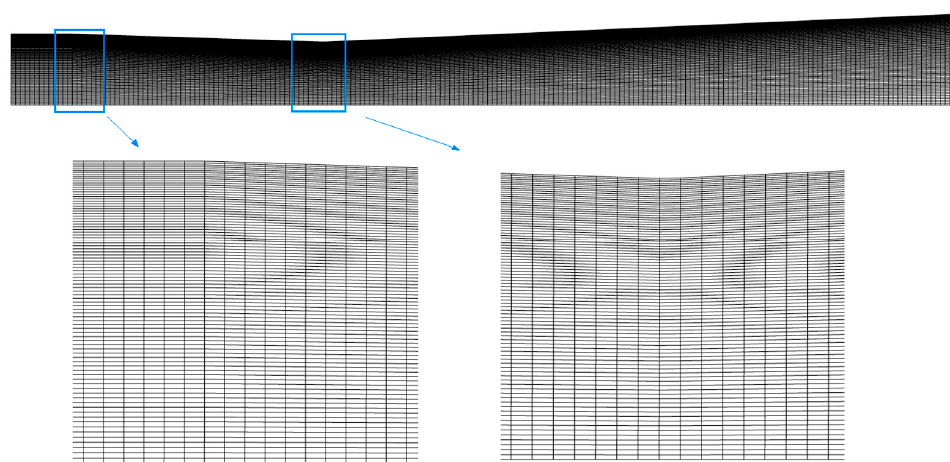
Figure 3. Pressure distribution along the Moore type “B” nozzle centerline as compared with exper- imental data (Moore et al. [4]). -0.2